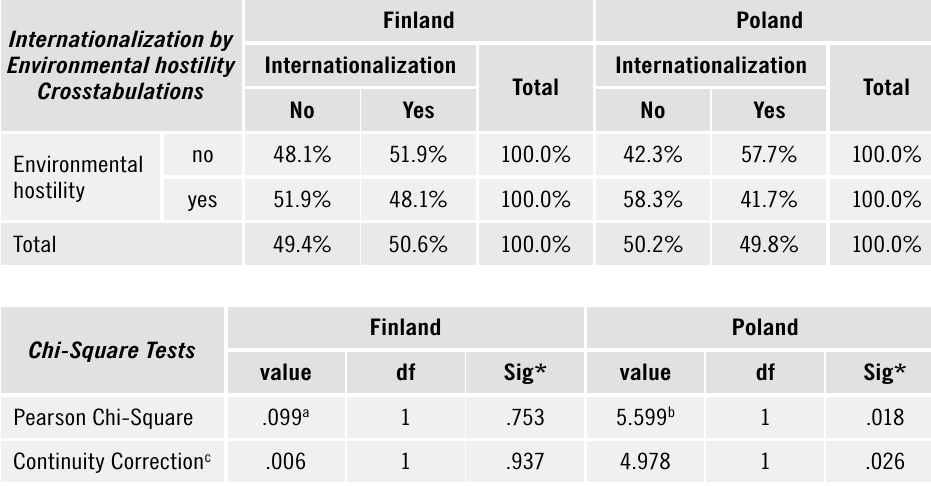
Table 6. Internationalization by environmental hostility crosstabulations Internationalization by Environmental